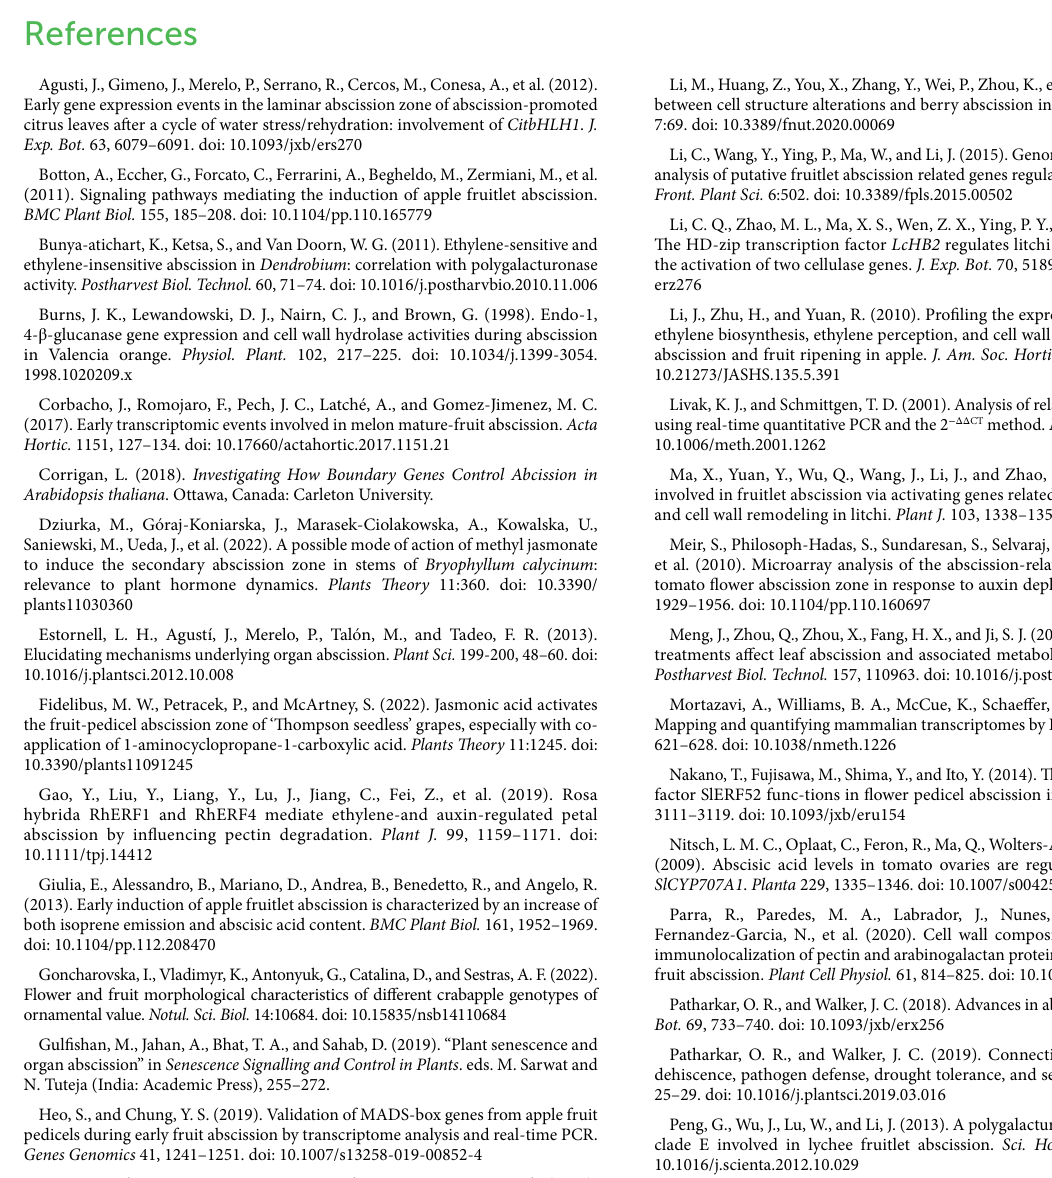
SUPPLEMENTARY FIGURE S1 Comparison of the different period of ornamental crabapple fruit. (A) Show the changes of fruit growth status of five cultivars of ornamental